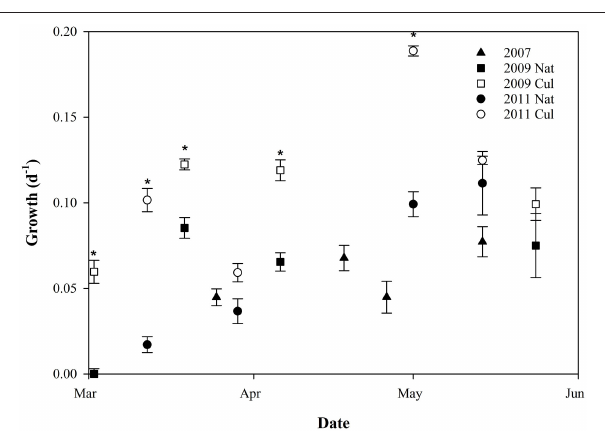
FIGURE 5 | Scatterplot of biovolume-specific growth rates (day − 1 ) through three seasons (mean ± SE). Filled symbols indicate nauplii fed natural seston (Nat), open symbols indicate nauplii fed cultured algae (Cul). Asterisk indicates growth periods where there is a difference between growth of nauplii fed natural seston and cultured microalgae (Student T -test, p < 0.05).